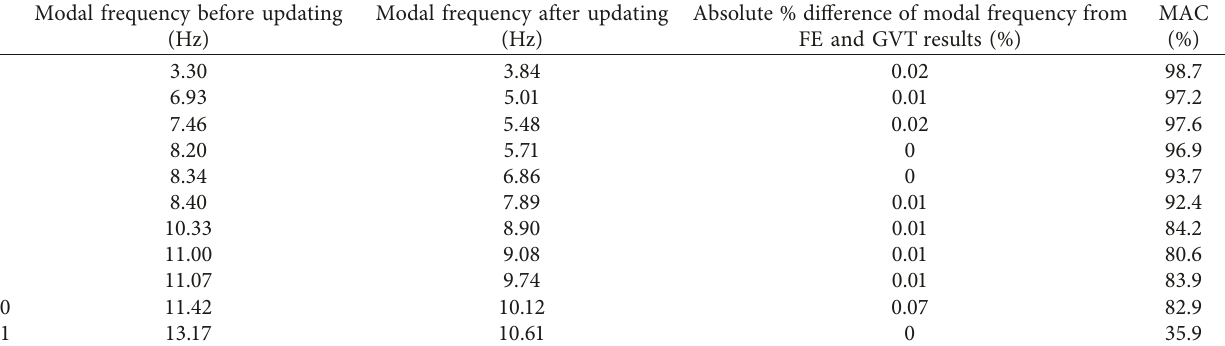
Table 5: Correlation data after model updating.